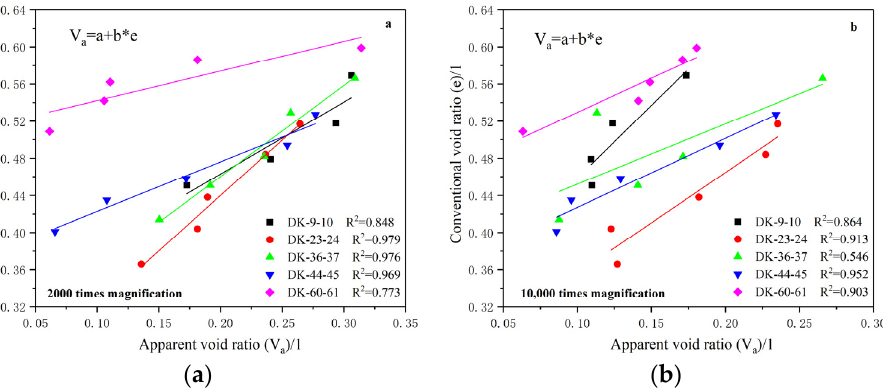
Figure 11. Relationship between the apparent void ratio and the conventional void ratio. ( a ) 2000 times magnification; ( b ) 10,000 times magnification.